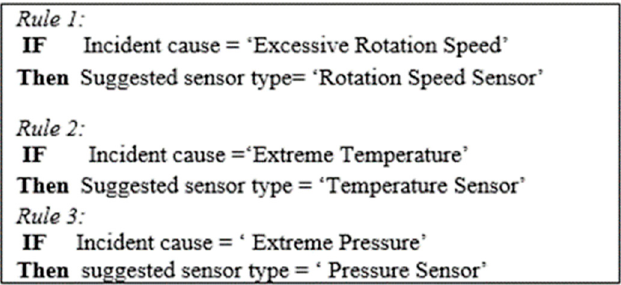
Figure 5. Examples of sensor type determination rules.